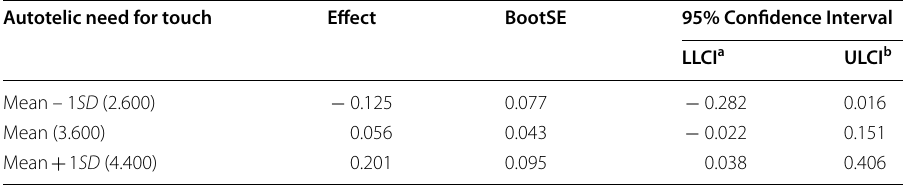
a LLCI: lower limit confidence interval